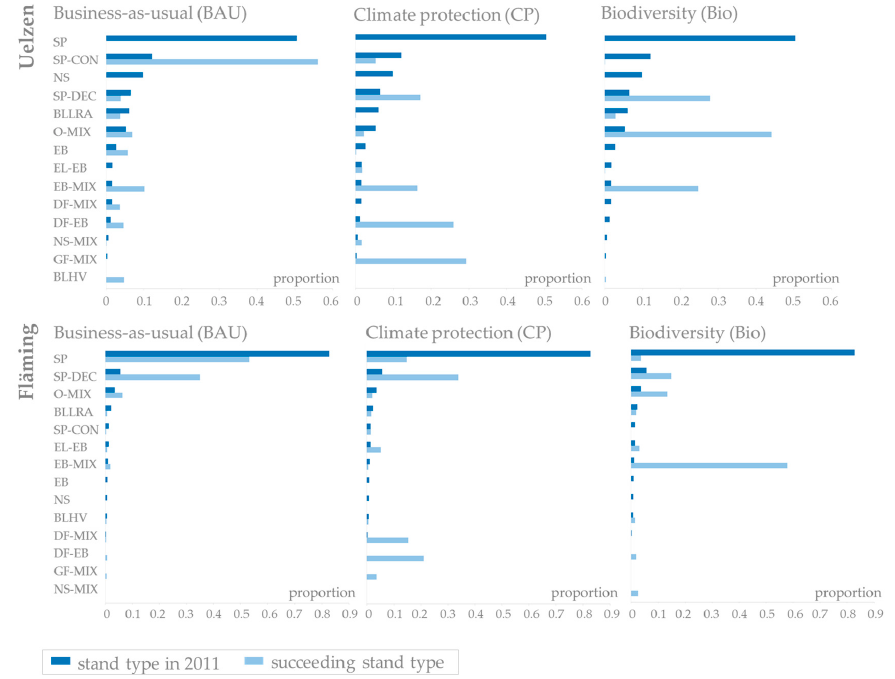
Figure 5. Frequency distribution of current stand type area (dark blue) and succeeding stand type area planned under constant site conditions (stage 1) in 2070 (light blue) under three silvicultural management strategies in Uelzen ( top row ) and Fläming ( bottom row ).